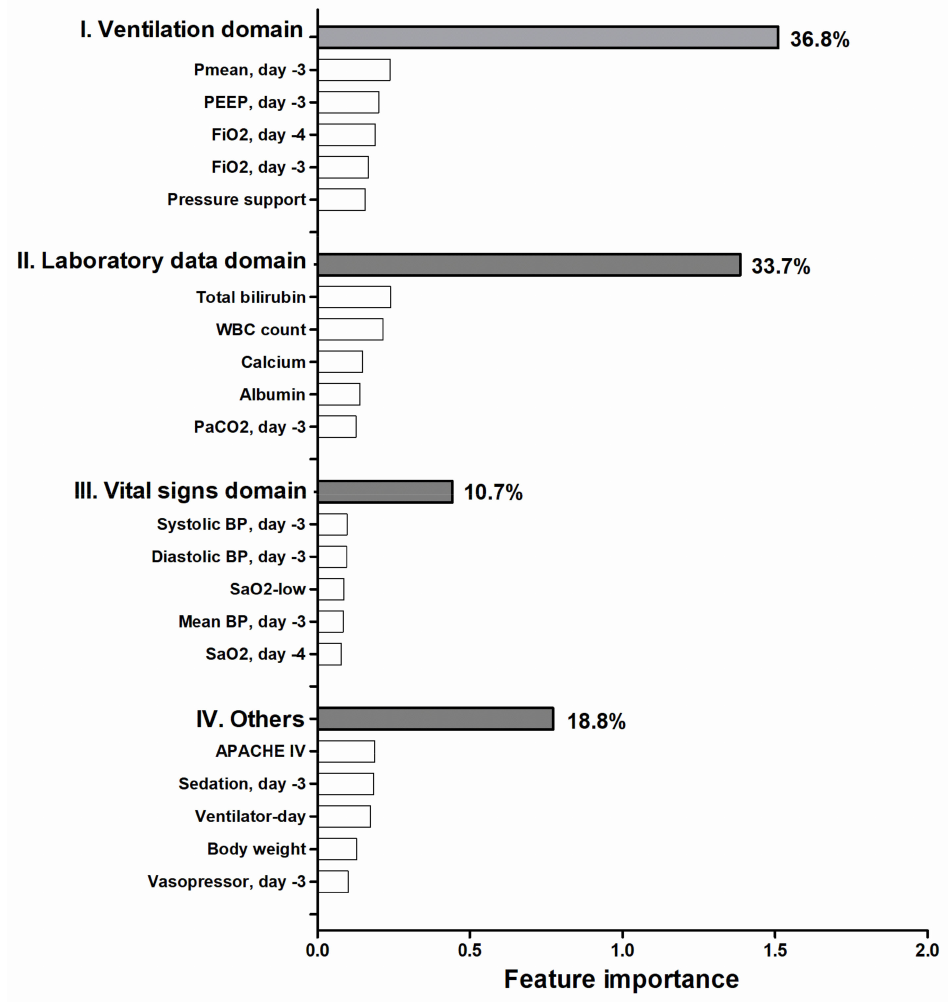
Figure 3. Cumulative relative feature importance of top 20 features categorized by main clinical domains in predicting successful weaning. Feature importance of each feature indicated how much each feature contributed to the model